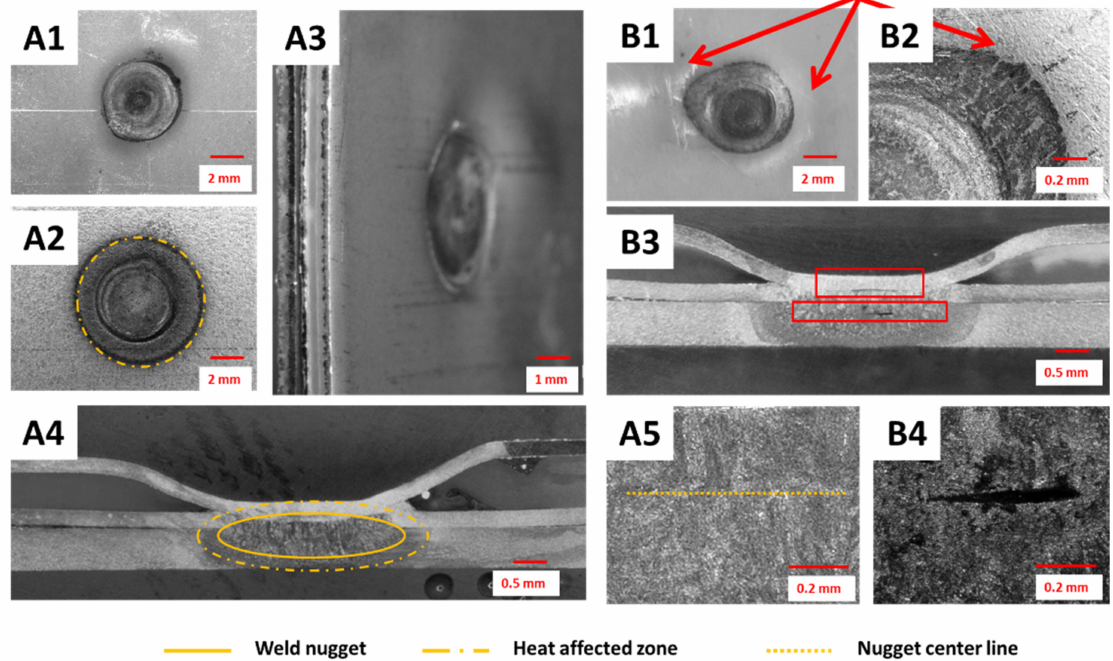
Figure 15. Examples of spot welds fabricated by ultrasonic-assisted RSW: properly ( A1 ) top view, ( A2 ) bottom view, ( A3 ) side view, ( A4 ) cross-section at low magnification, and ( A5 ) weld nugget at high magnification and non-properly formulated ( B1 ) top view, ( B2 ) top view magnified, ( B3 ) cross-section at low magnification, and ( B4 ) weld nugget at high